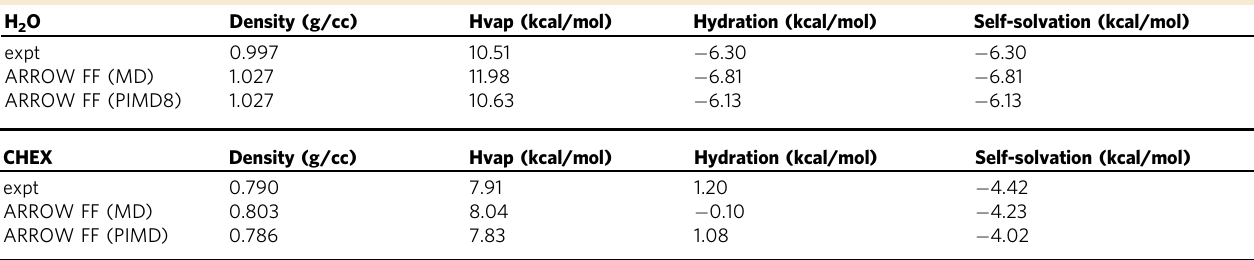
PredictionswereperformedbyclassicalsimulationsandwithinclusionofNQE.Allnumbersareingoodagreementwiththeexperimentalvalues,withPIMDsimulationsbeingsigni fi cantlycloserthanthe classicalMDones.Theself-solvationofwaterisasuccinctmeasureofmodelaccuracyandwerecommenditsdeterminationforallwatermodels.Forwatertheself-solvationandhydrationareobviously identical.